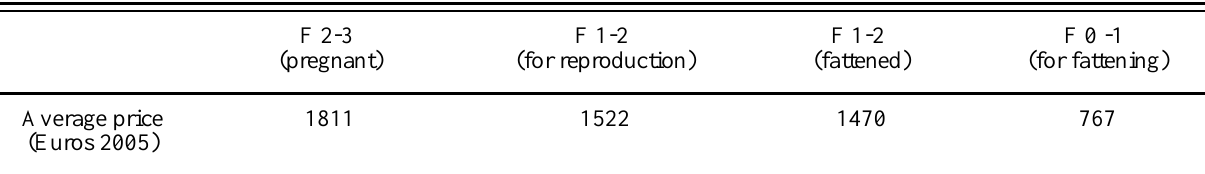
Table 2. Average prices of the Limousin females (F) sold for reproduction or for